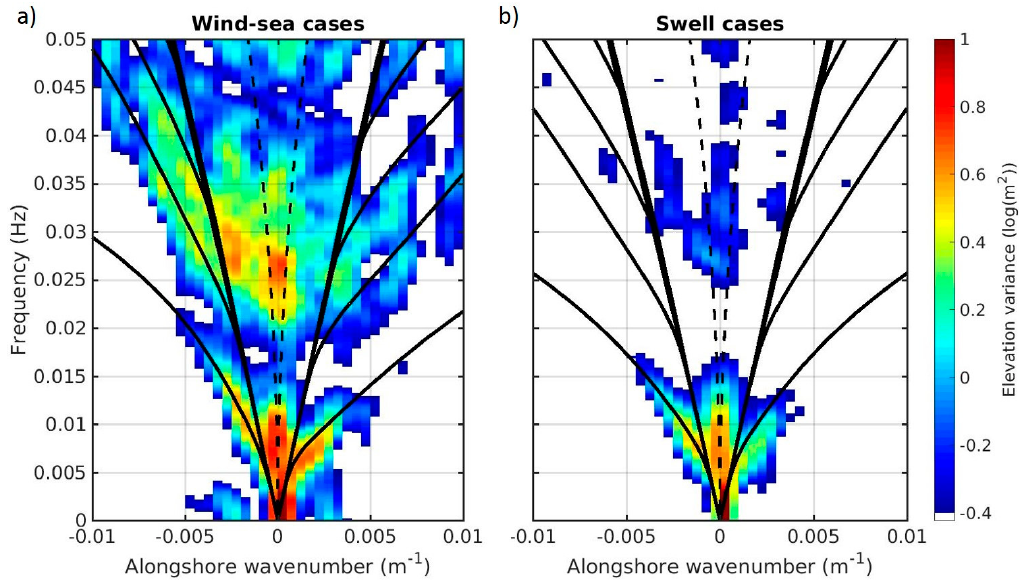
Figure 7. Elevation spectra averaged over ( a ) wind-sea cases (between 4 pm and 7 pm), ( b ) swell cases (between 7 am and 10 am). The colour bar denotes the elevation variance (m 2 Hz − 1 m − 1 ), plotted on a logarithmic scale with lower values of elevation variance appearing in white. Black solid lines are theoretical dispersion curves (calculated based on the observed alongshore current at the time) and black dashed lines represent the cut-off between edge waves and leaky waves. Positive (negative) wavenumbers represent edge wave progressing southward (northward).